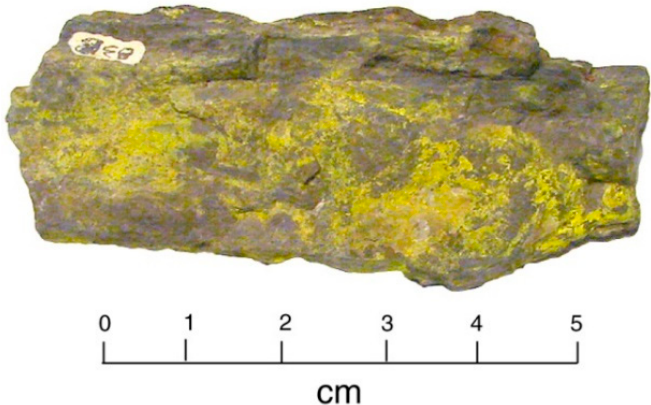
Figure 15. Carnotite-bearing fossil wood from Judd Claim, White Canyon District (UT).